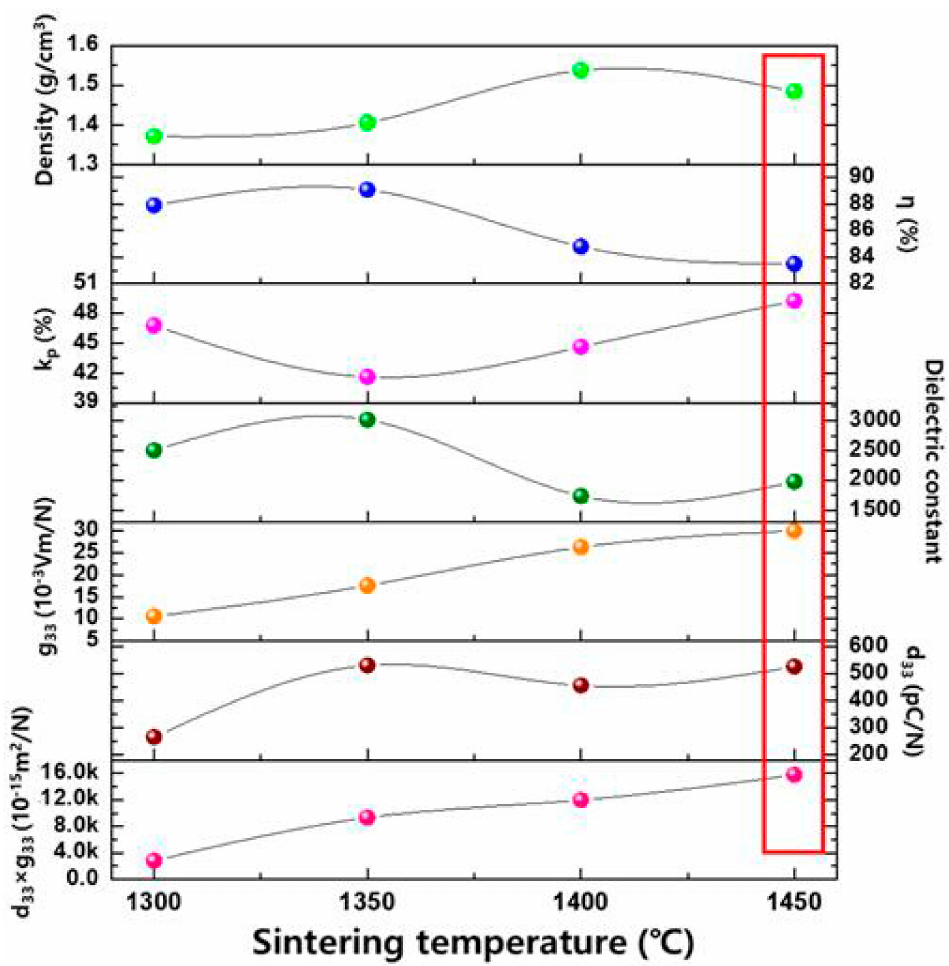
Figure 2. Piezoelectric and dielectric properties of the BCTZC 0.3 ceramics sintered at various temperatures. Table 1. Piezoelectric and dielectric properties of BCTZC 0.3 samples according to their sintering temperatures. Sintering Temperature ( ◦ C)